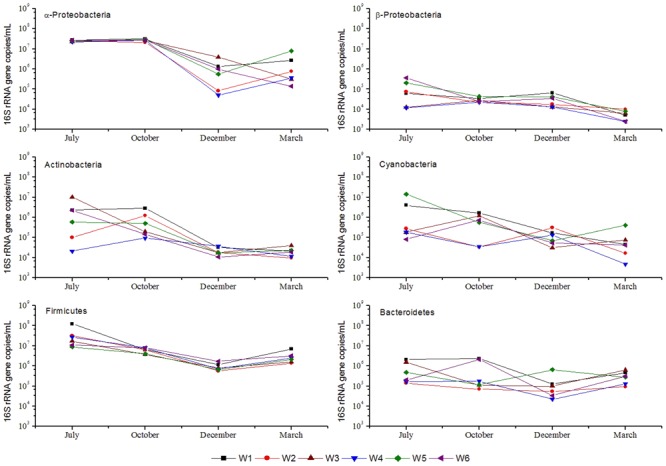
16S rRNA gene abundance (qPCR quantification) of major phylogenetic groups from coastal bacterioplankton assemblages in 6 stations near Qinhuangdao coastal area. The symbols and lines in black, red, green, blue, cyan, and magenta represent stations W1, W2, W3, W4, W5, and W6. Values on Y-axis are plotted in log-scale.